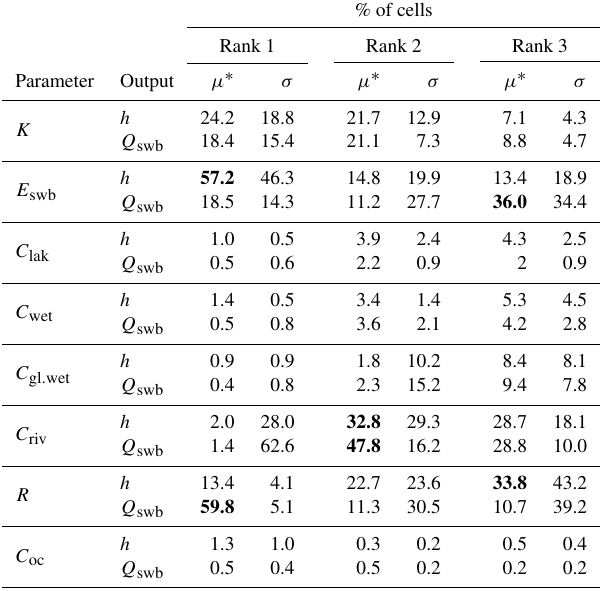
Table 3. Percentage of cells for which parameters are ranked 1 to 3 based on µ ∗ and σ . Percentages are shown for each model output, h and Q swb . For example, h is the most sensitive to parameter E swb (rank 1) in 57.2% of all grid cells, while R is the most important parameter for Q swb in 59.8% of those cells. Significant values are highlighted in